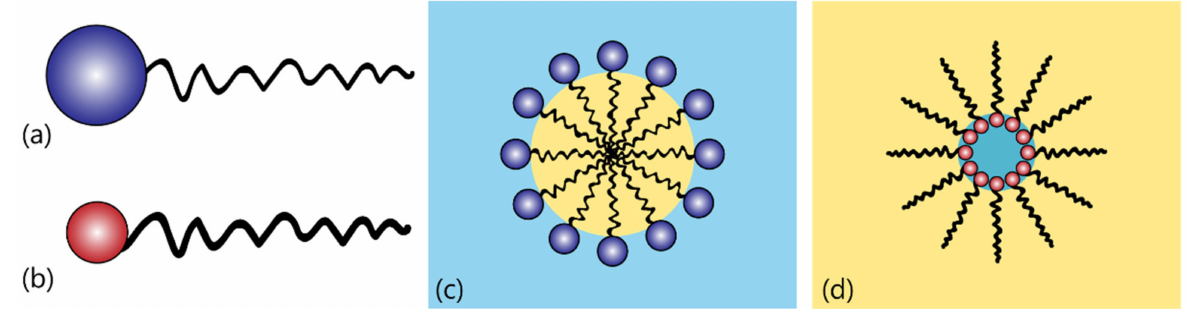
Figure 3. Illustration of the surfactant molecules’ arrangement in single emulsions: ( a ) hydrophilic emulsifier molecule (high HLB); ( b ) lipophilic emulsifier molecule (low HLB); ( c ) micelle in an O/W emulsion; ( d ) reverse micelle in a W/O